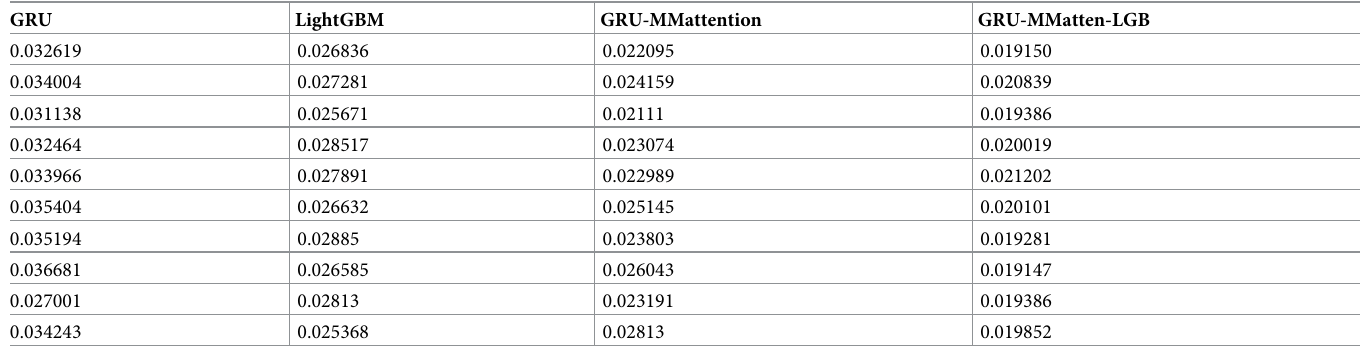
Table 6. The MAPE of the noise experiment on all methods.